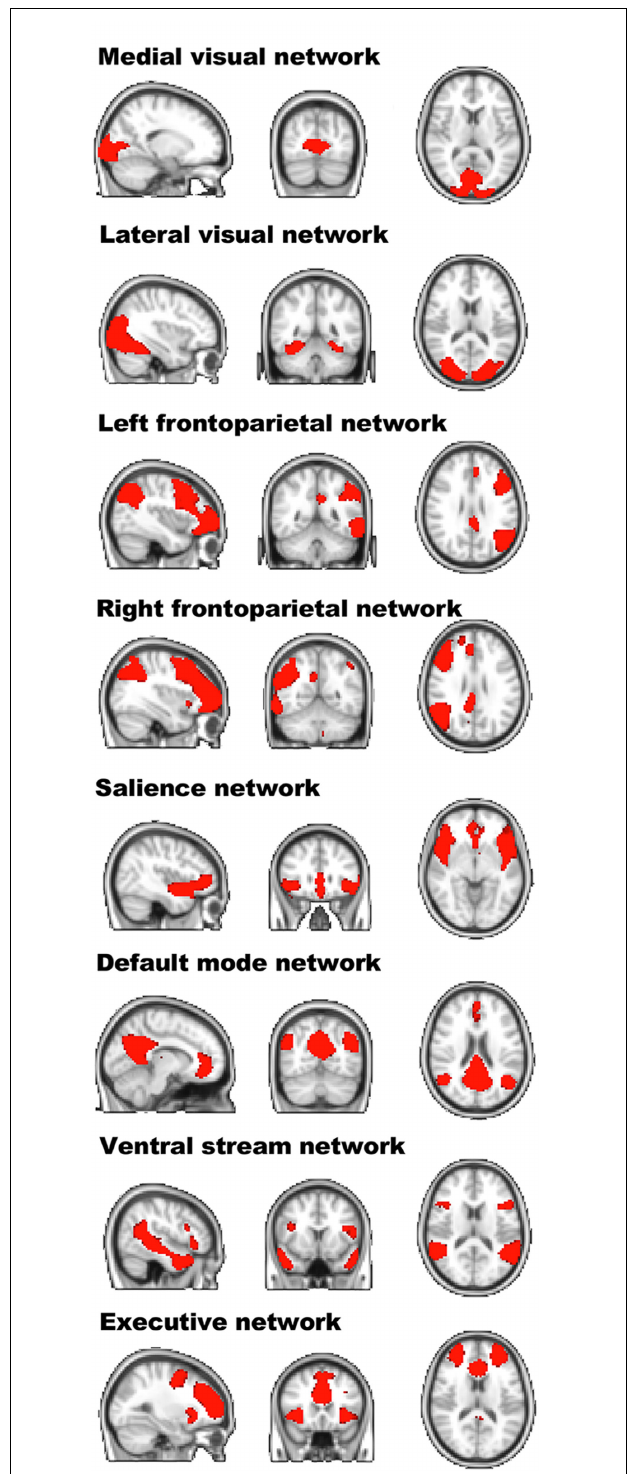
FIGURE 2 | Spatial layout of the independent components of interest of the entire sample. Visualization of the resting-state independent components extracted from the entire sample. For each component, the sagittal, coronal, and transversal perspectives are depicted (radiological convention).